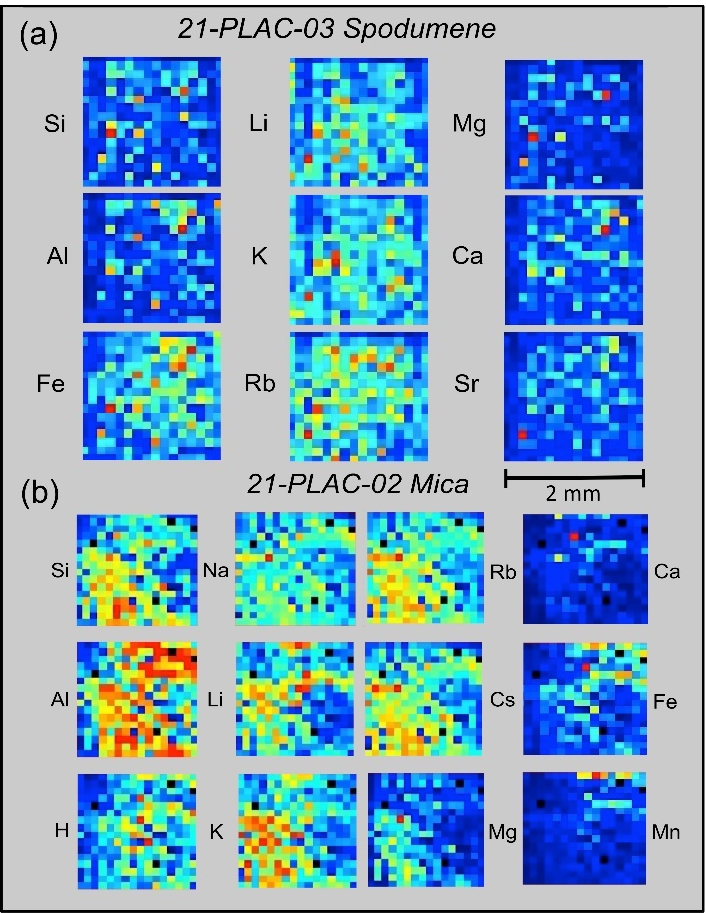
Figure 9. Elemental distribution ‘heat maps’ obtained by Z-300 raster scanning of a spodumene ( a ) and muscovite ( b ) specimens from outcrops on the Carolina Lithium Project prospect in Gaston County, N.C. Elemental emission intensity variations for different elements are shown in a gradient of colors that varies from red for high relative abundance to blue for low relative abundance. The spectral lines used for these microchemical maps are: Al = 396.15 nm, Ca = 393.37 nm, Cs = 852.11 nm, Fe = 438.35 nm, H = 656.28 nm. K = 766.49 nm, Li = 670.79 nm, Mg = 279.55 nm, Mn = 403.31 nm, Na = 588.99 nm, and Si = 288.16 nm.